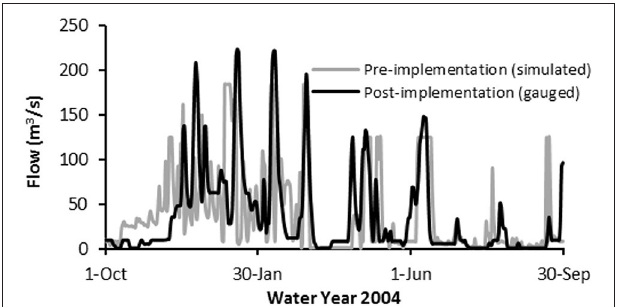
FIGURE 3 | Flow regime on the Green River below the Green River Dam following implementation of environmental flows (“Post-implementation”) compared to the flow regime produced by previous operations (“Pre-implementation”). The post-implementation hydrograph comes from gauged data whereas the pre-implementation hydrograph was modeled by applying the previous operation scheme to the same gauged flow data. From Warner et al.